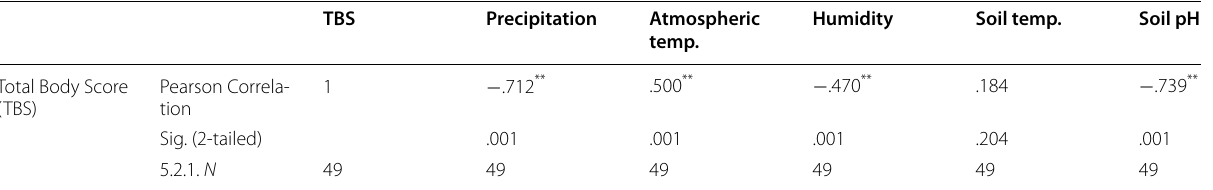
Key to quality of